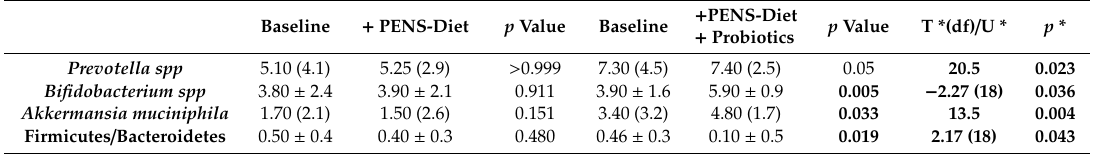
+ PENS-Diet / U * p * + Probiotics p Value T *(df)